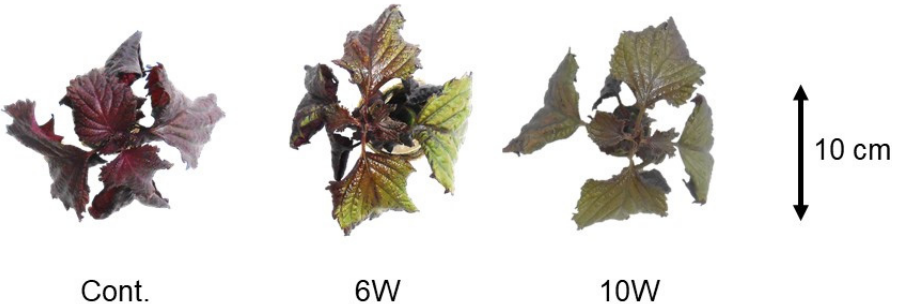
Figure 4. Red perilla was grown for 3 d under different UV irradiation intensities (experiment 1). Plants were exposed to UV-B irradiation at 0 (control), 6 (6 W), and 10 W m − 2 (10 W). The RA concentration was approximately 40% and 120% higher at 6 and 10 W m − 2 , respectively, than that of the control (Figure 5), whereas the PA concentration did not differ among the treatments. The ANT concentrations at 6 and 10 W m − 2 were significantly lower than that of the control, and the ORAC values at both 6 and 10 W m − 2 were significantly higher than those of the control.